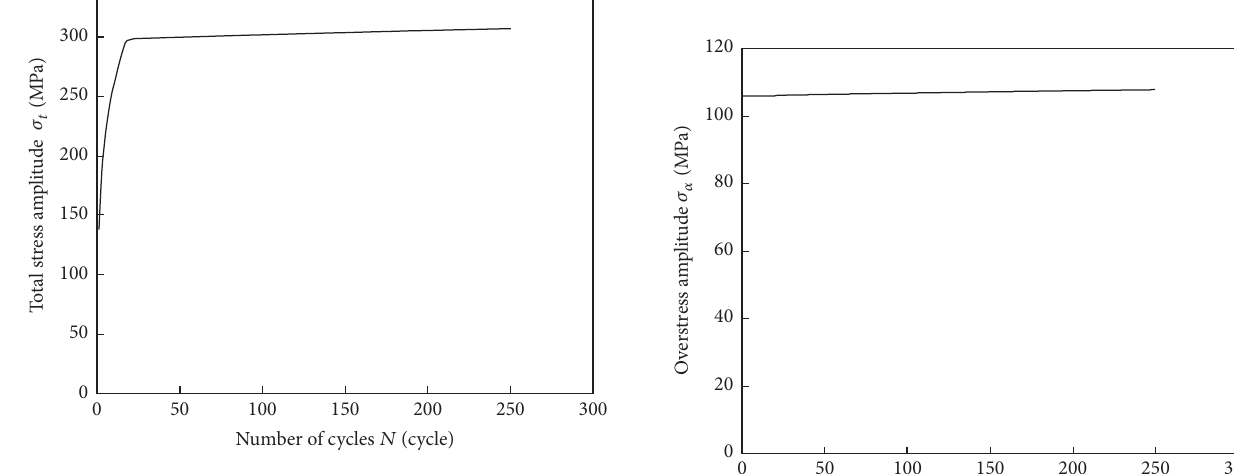
Figure 13: Number of cycle effects on back stress amplitude for a 316 stainless steel.